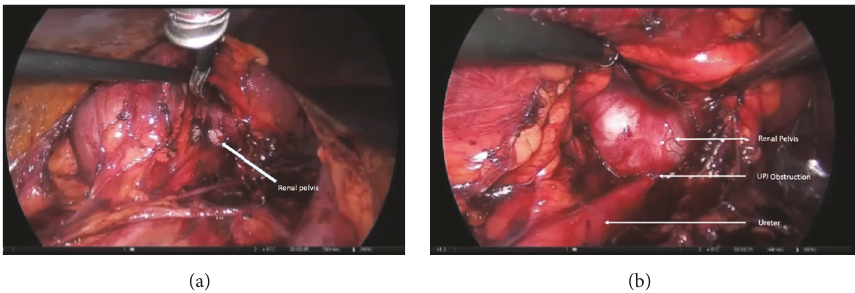
Figure 2: Exposure of the intrarenal pelvis and relatively high insertion of the